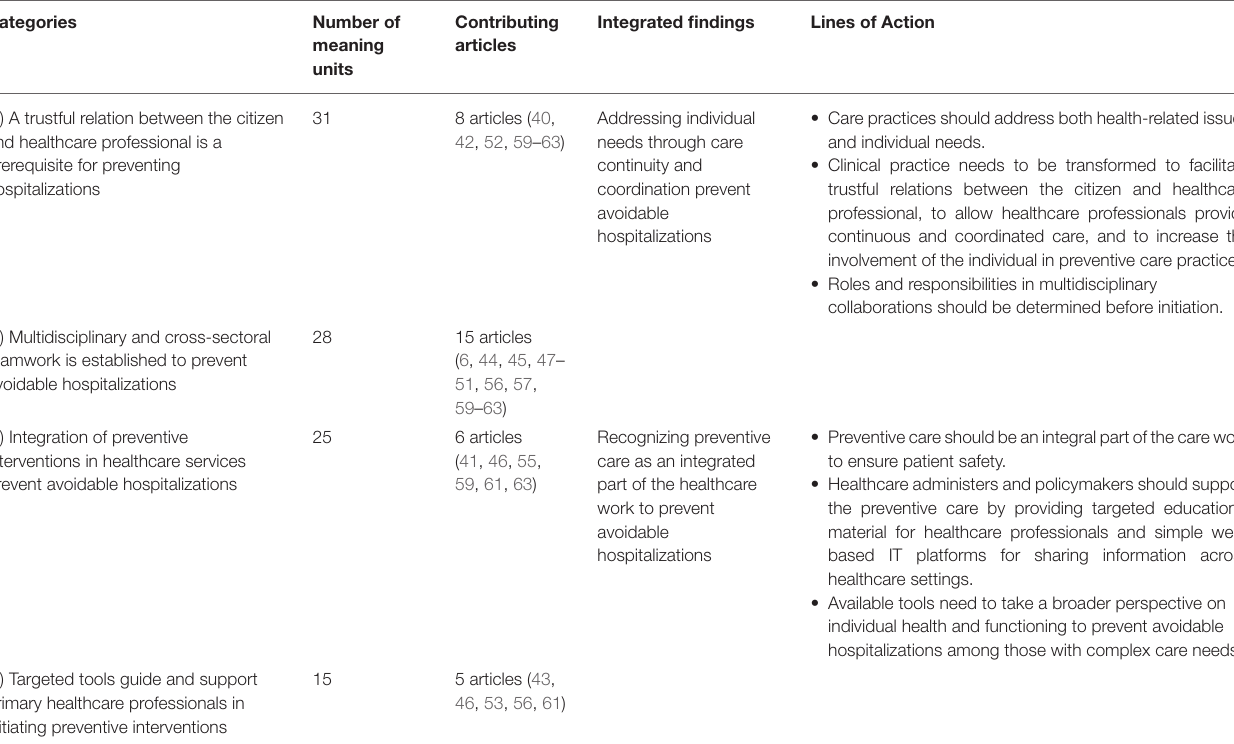
TABLE 3 | Summary of the main